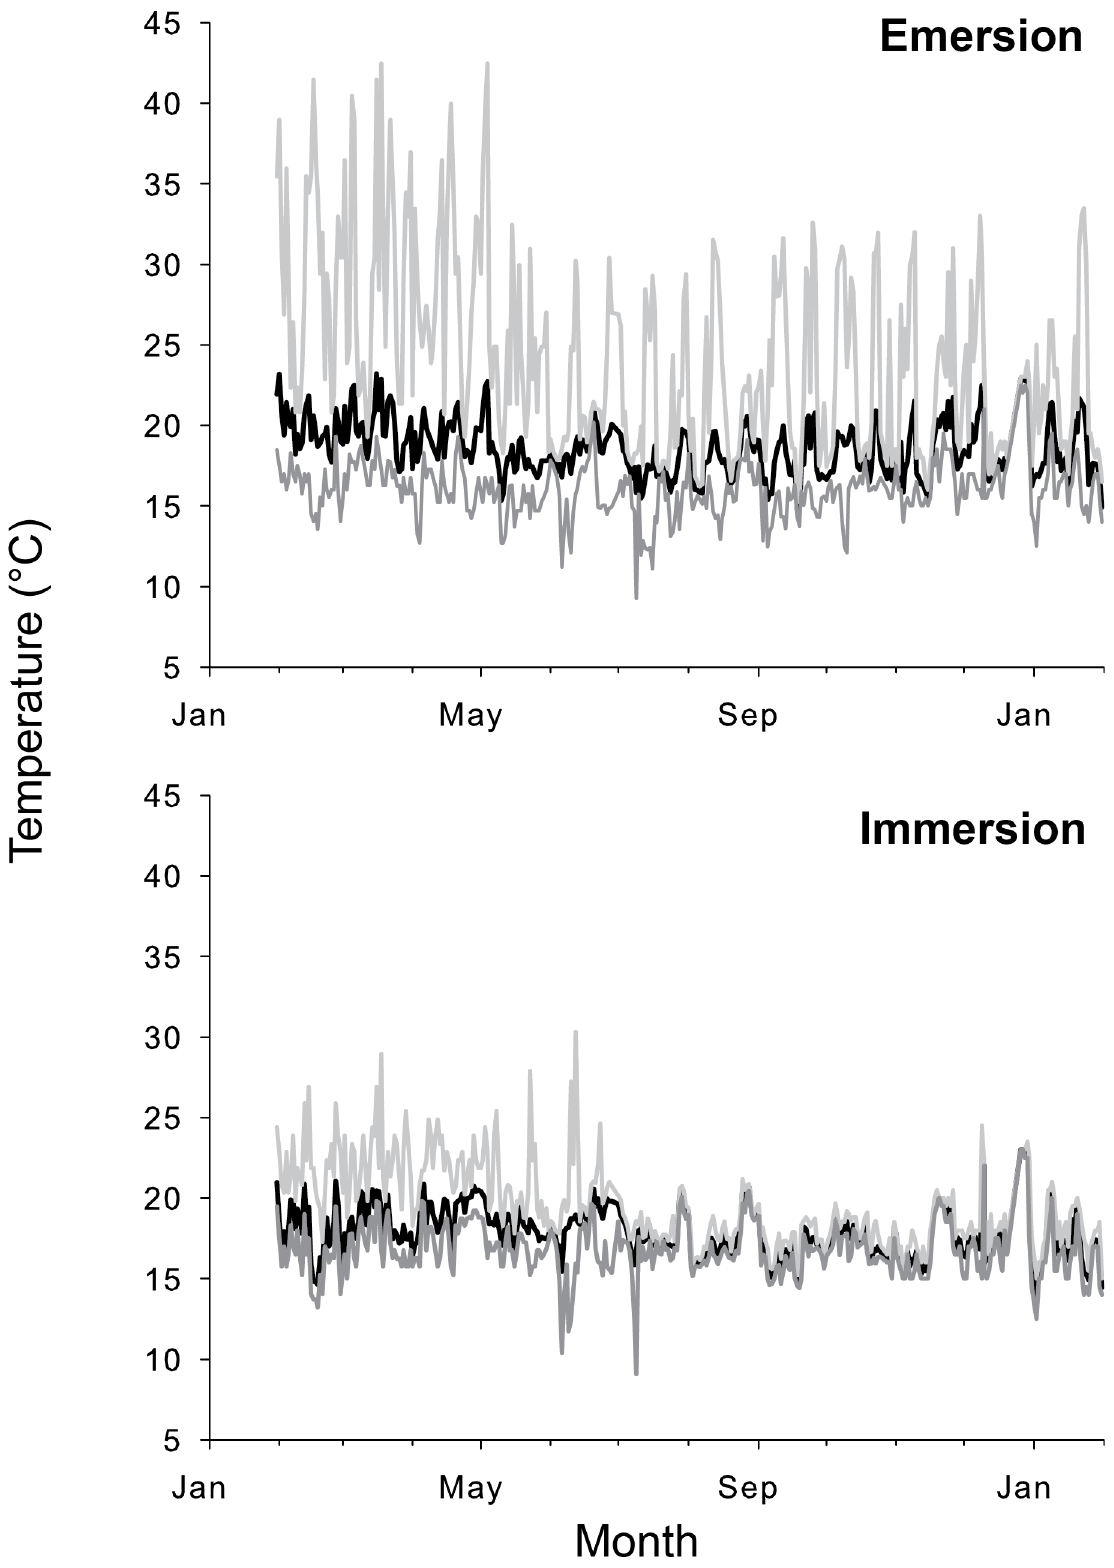
Fig 2. Daily mean (black line), maximum (light grey line) and minimum (dark grey line) temperatures recorded in-situ using robomussel data loggers at Morgan Bay during both low and high tide.